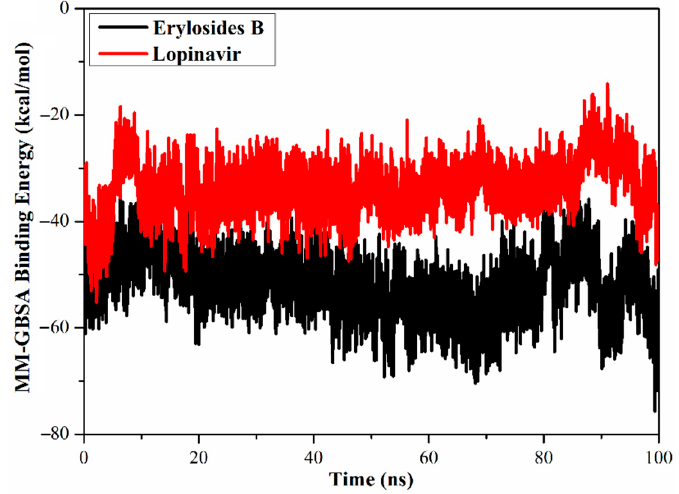
Figure 5. Calculated MM/GBSA binding energy per frame for erylosides B (black) and lopinavir (red) with M pro over 100 ns MD simulations.